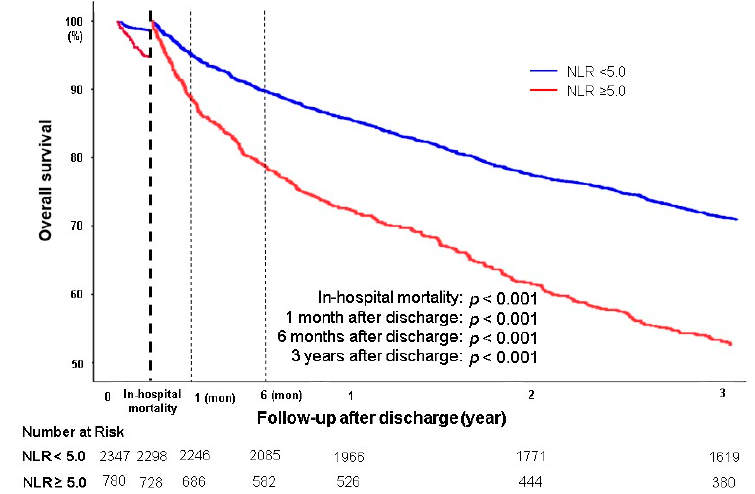
Figure 3. Overall in-hosptial mortality and 3-year survival after discharge of HF patients whose aggravating factor were not-infection or non-ischemia divided by NLR 5.0.